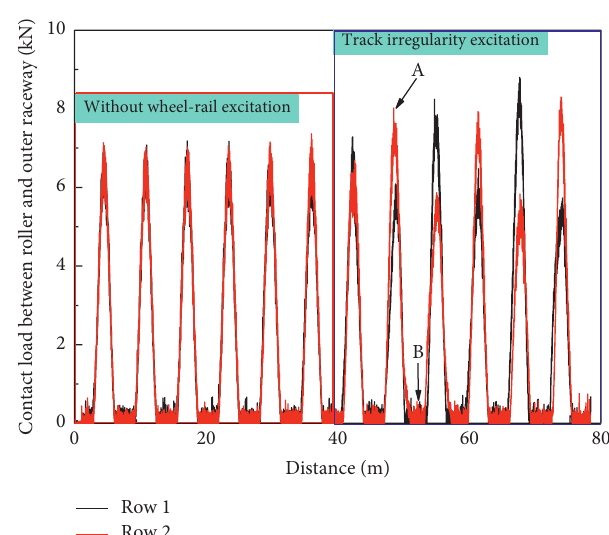
Figure 14: Contact load history of the roller and outer